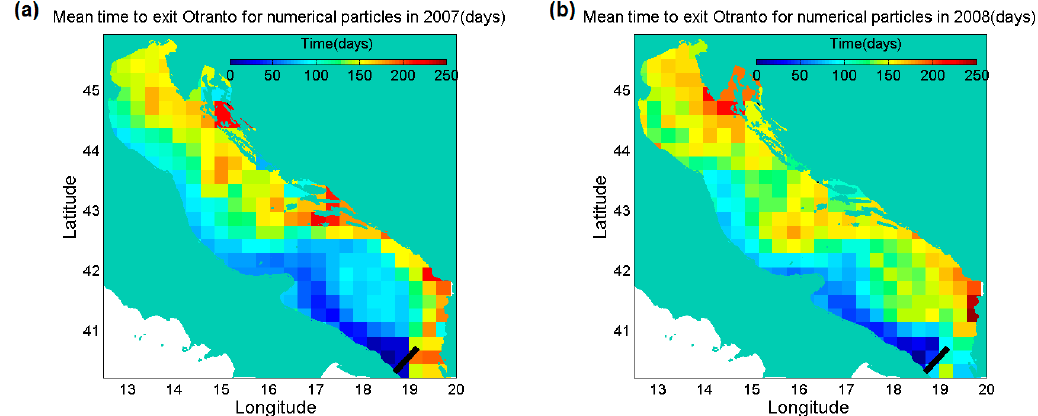
Figure 4. Mean time to exit the Strait of Otranto (days) for numerical particles during 2007 ( a ) and 2008 ( b ).